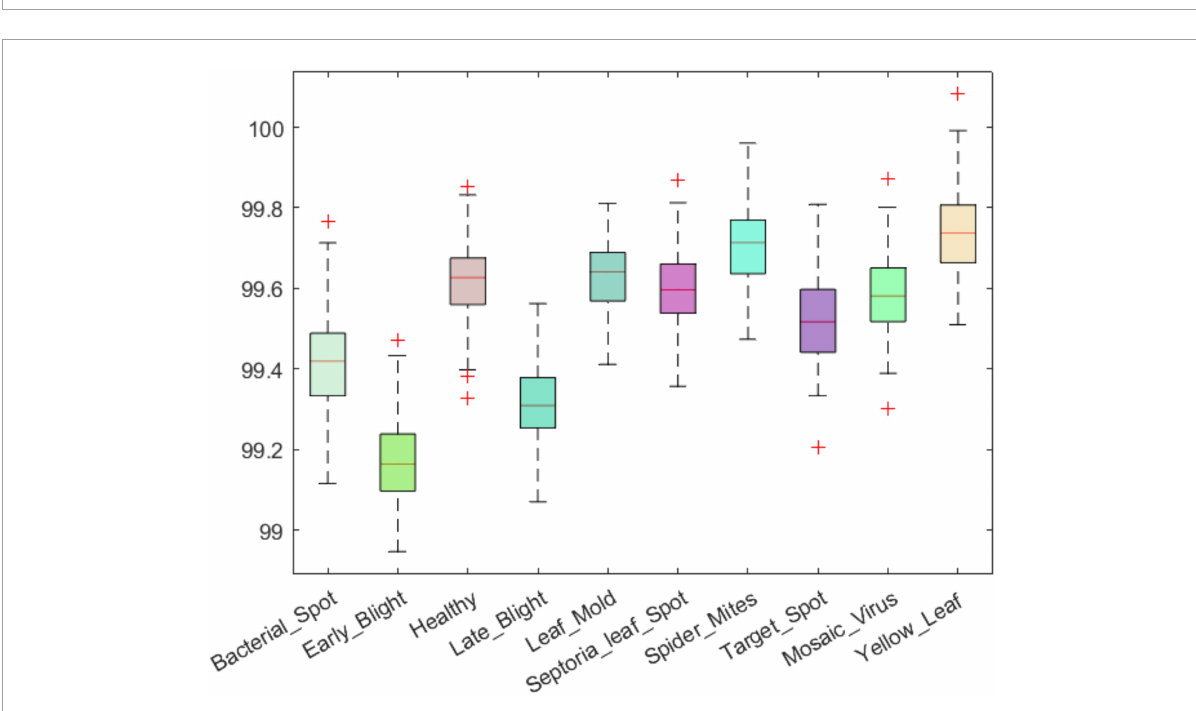
FIGURE9 A pictorial depiction of the class-wise recall values obtained for the DenseNet-77-based CornerNet model.